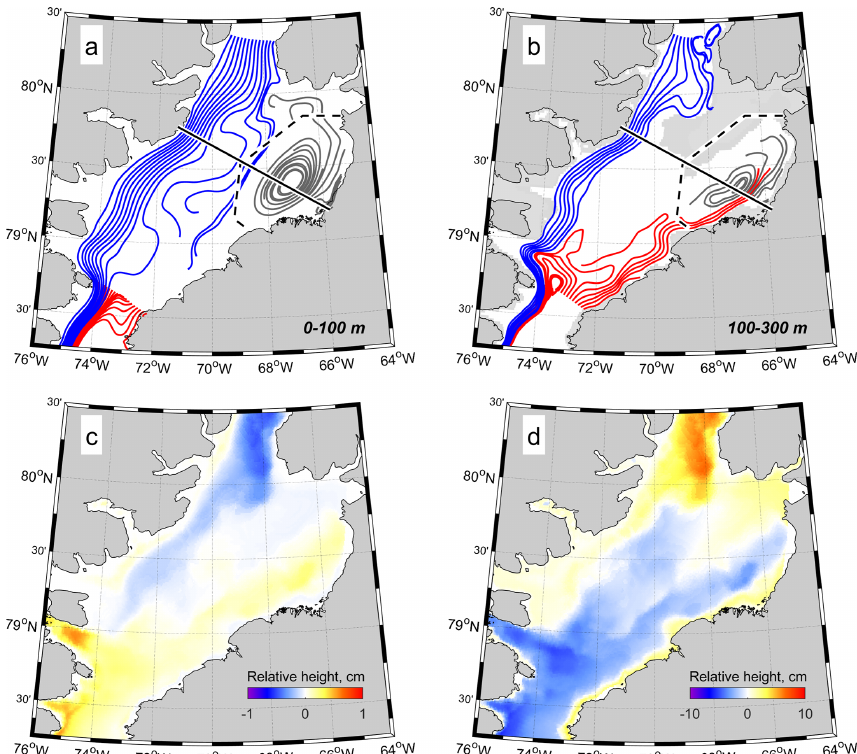
Figure 7. (a–b) The trajectories of water parcels calculated from the mean 2006–2010 model current velocities averaged within 0–100 and 100–300m, respectively. The blue, red and gray lines correspond to three main circulation patterns in the region (see more details Sect. 3.4). The black dashed line envelopes the region used for vorticity calculation (Fig. 8) and the solid line shows the position of transect presented in Fig. 9. The shaded area in (b) corresponds to the regions shallower than 150m. The spatial distribution of the mean winter (November–June) thermosteric and halosteric sea level anomalies is shown in (c) and (d) ,